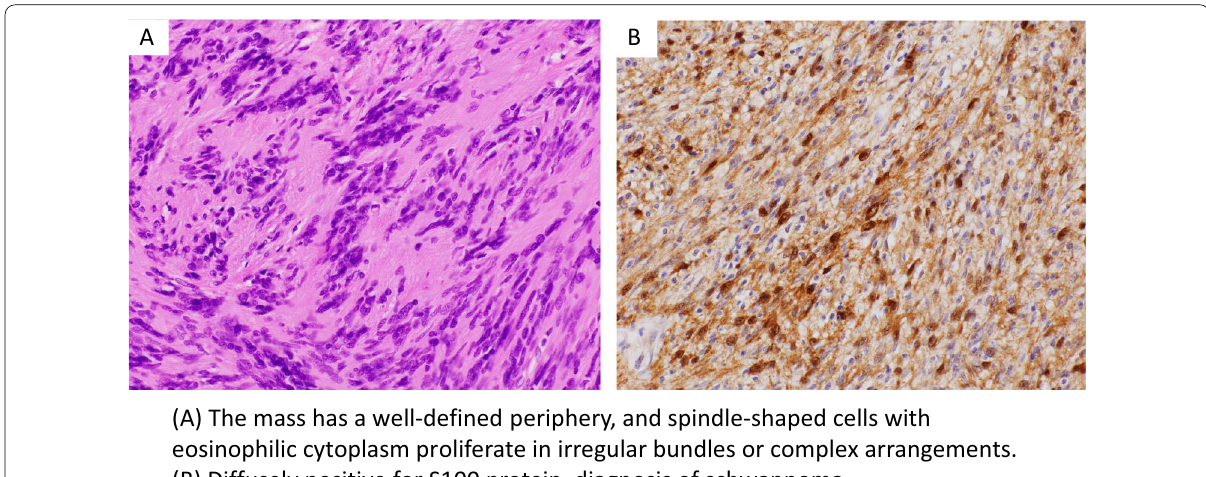
Fig. 4 Histological findings of cervical